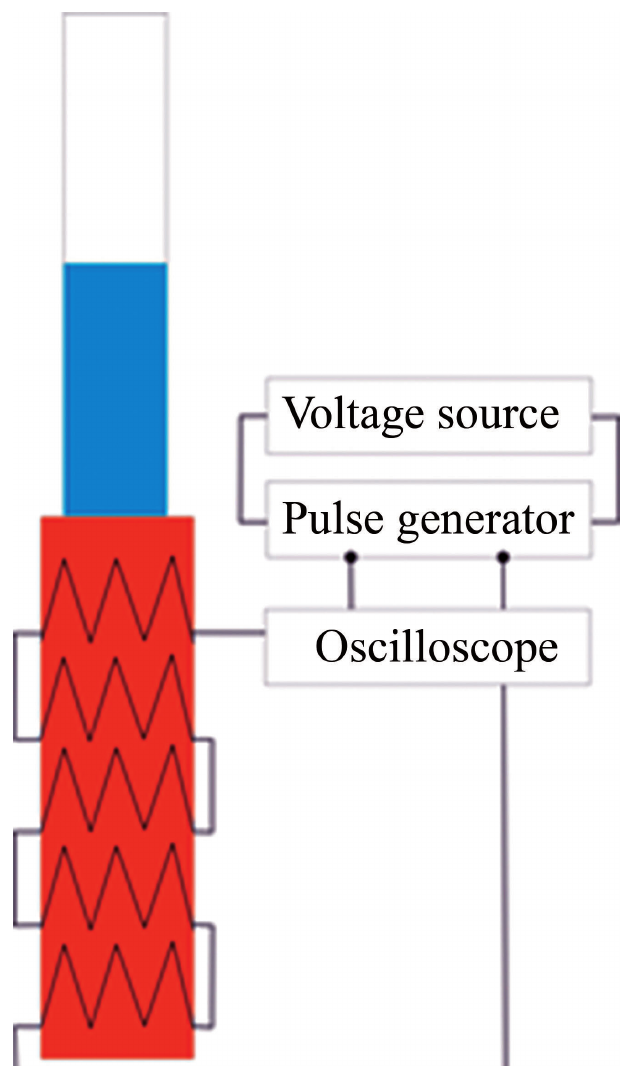
Fig. 4 - Illustration showing experimental